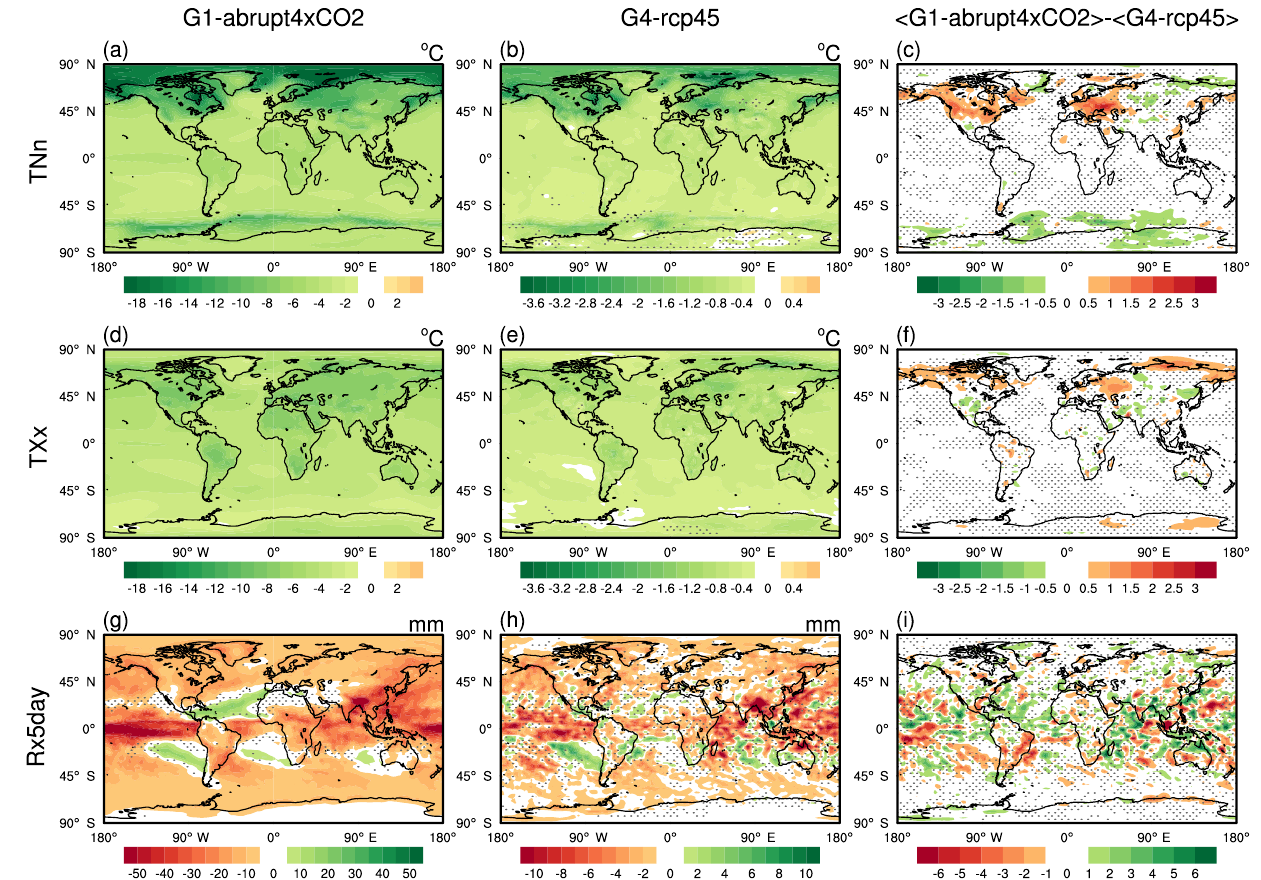
Figure 4. Geographical distributions over the 40-year analysis periods of the differences G1 − abrupt4 × CO2 (a, d, g) , G4 − rcp45 (b, e, h) , and between normalized G1 − abrupt4 × CO2 and G4 − rcp45 (c, f, l) for the extreme indices TNn (a, b, c) , TXx (d, e, f) and Rx5day (g, h, l) . Stippling indicates regions where fewer than five of six models agree on the sign of the model response. Note that panels have different colour